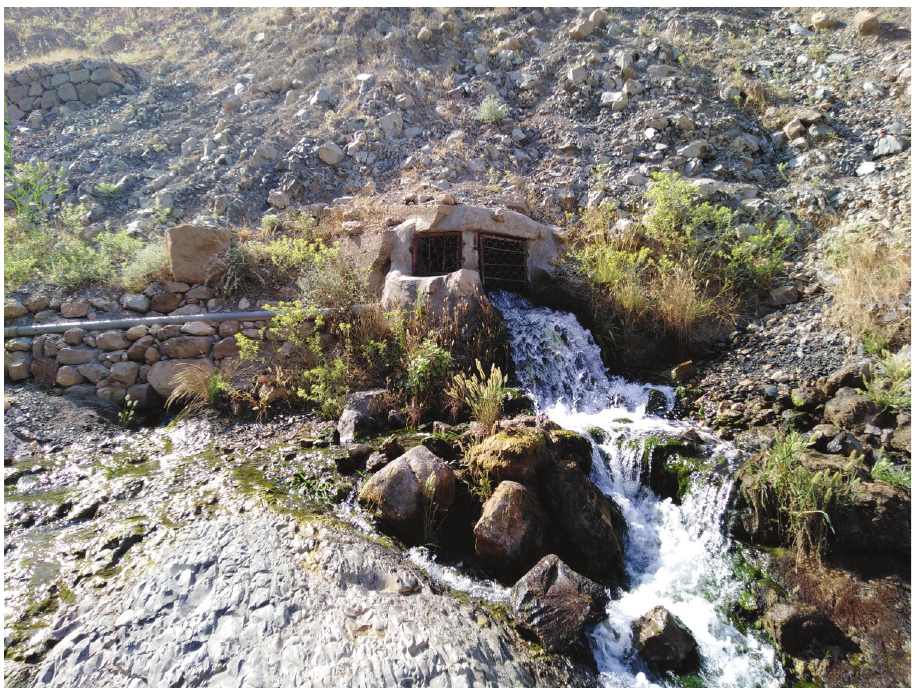
Figure 1. Photo of Ganow spring, the type locality of Asellus ismailsezarii sp. nov., Tuveh village, Andimeshk, Khuzestan Province, Iran. Stream width is about one